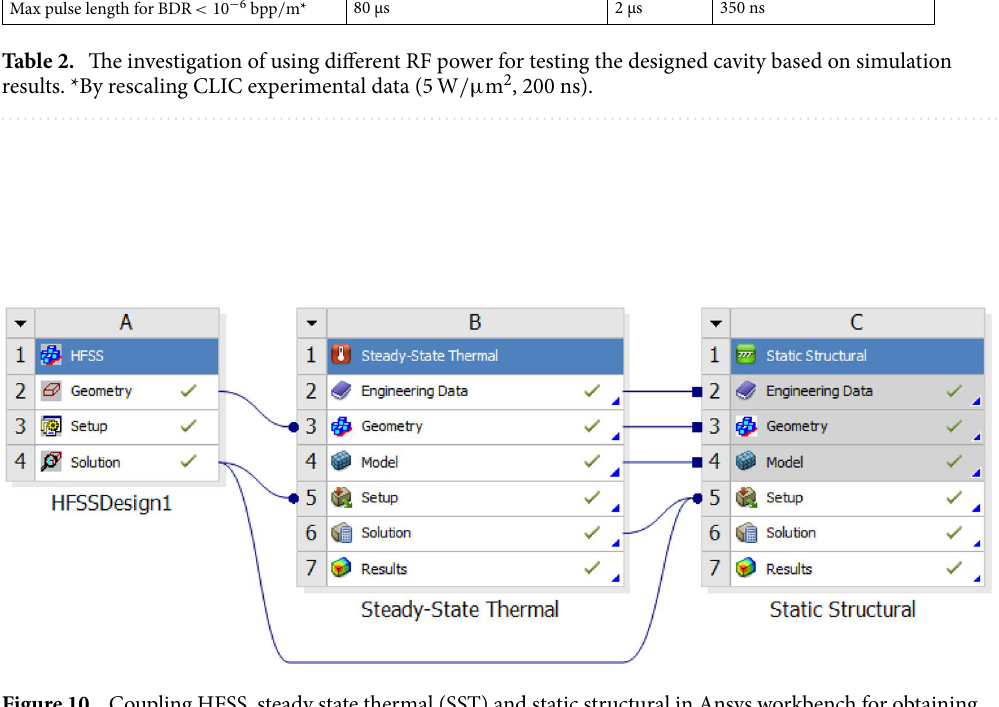
Figure 10. Coupling HFSS, steady state thermal (SST) and static structural in Ansys workbench for obtaining the frequency